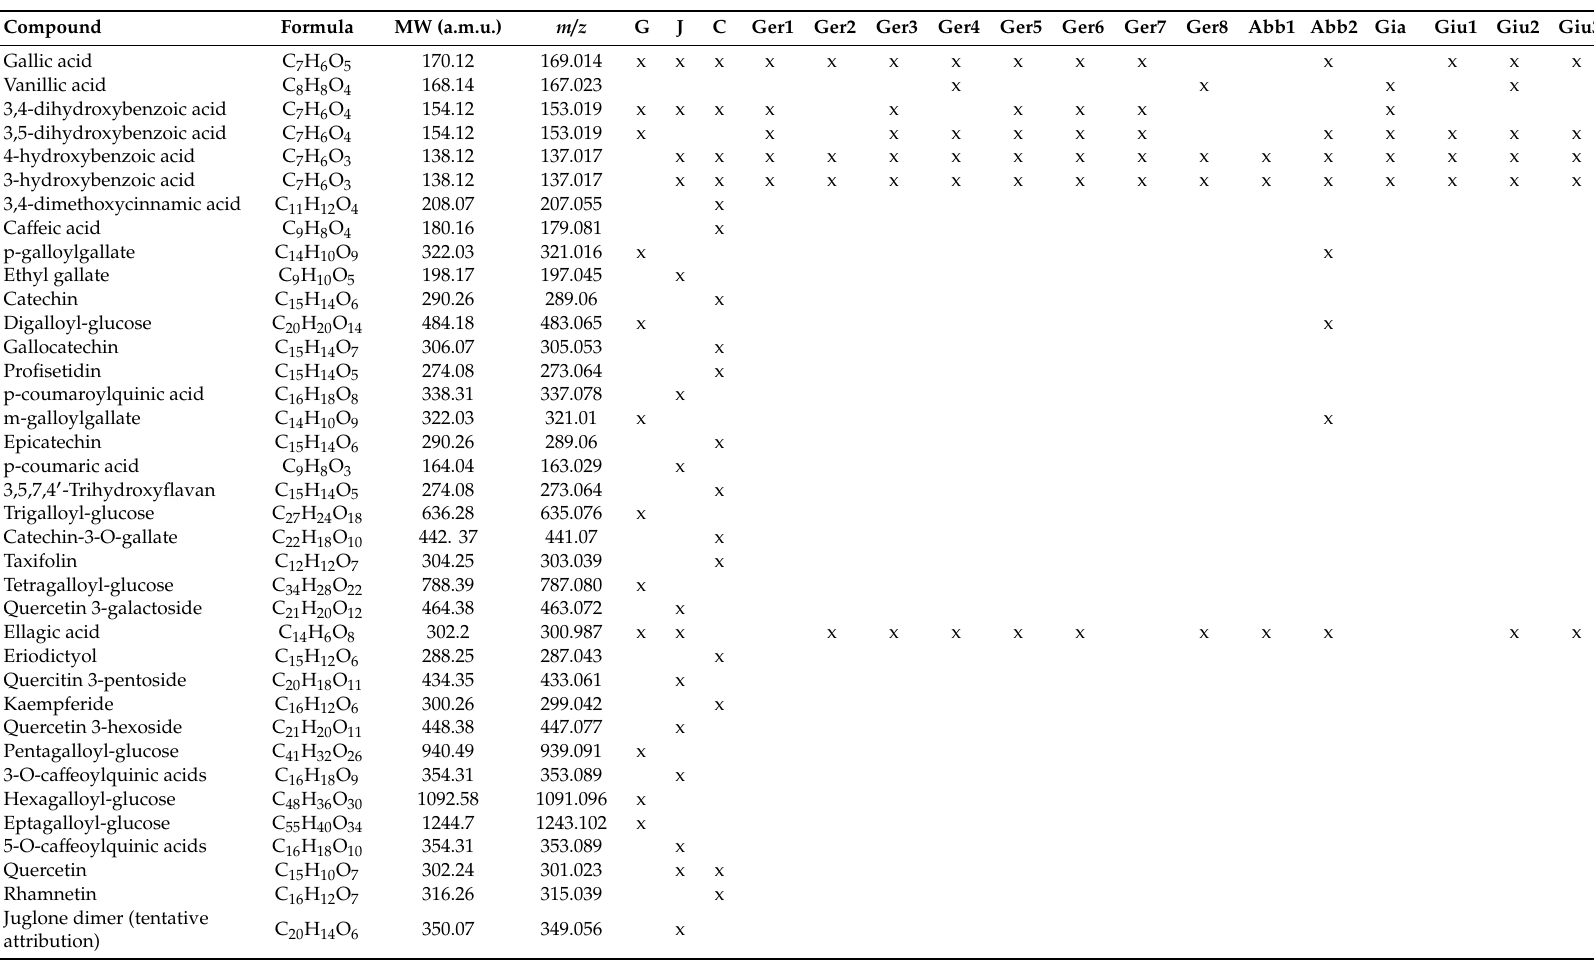
Table 1. List of identified compounds in reference and historical samples. For each compound, the chemical formula, molecular weight, molecular ions, and retention times are presented. In the case of undistinguished isomers, the retention time reported is relative to the first one eluted. The labels G, J, and C indicate reference samples dyed with gallnuts, walnut, and catechu,